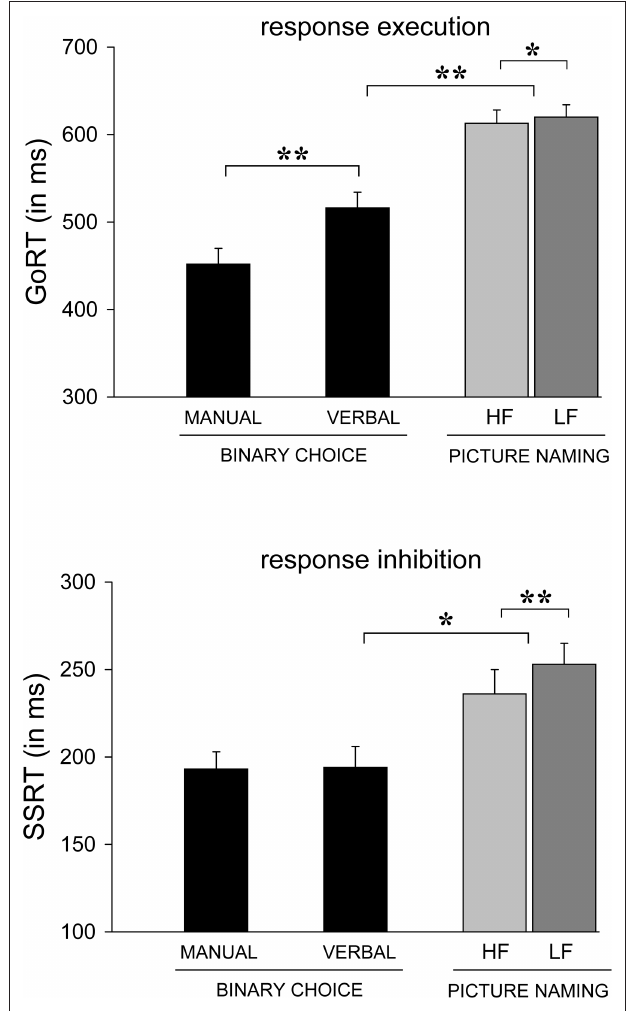
Figure 3 | Mean go rT (upper panel) and SSrT (lower panel) for manual and verbal binary responses in the binary-choice tasks (experiment 1) and for verbal responses to high-frequent (HF, light-gray bars) and low-frequent (LF, dark-gray bars) pictures in the picture-naming task (experiment 2). * p < 0.05; ** p <